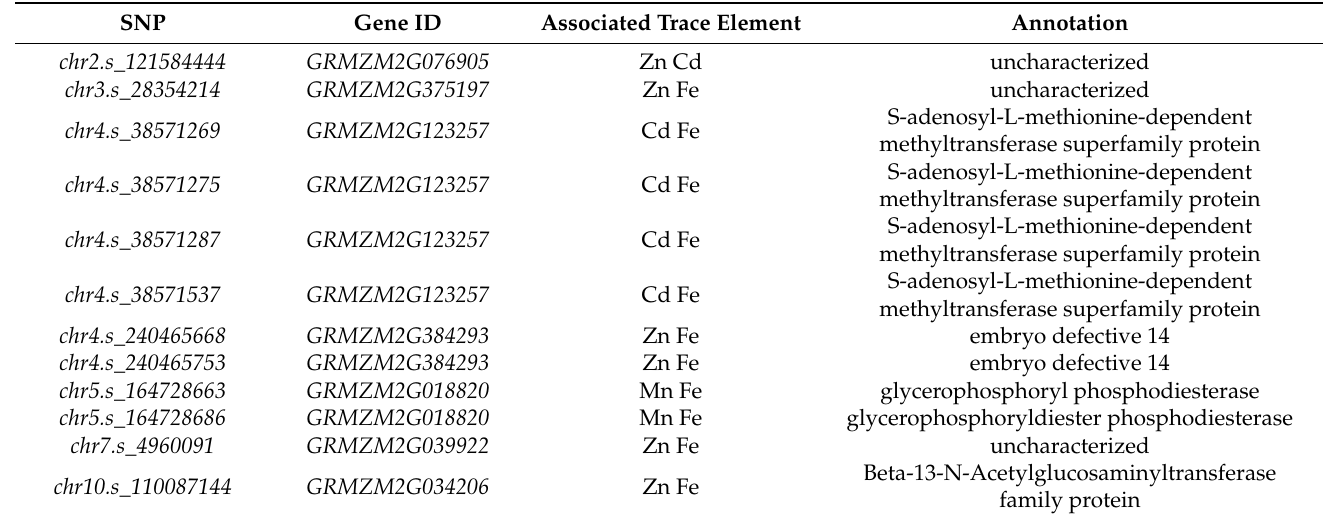
located within the coding region.